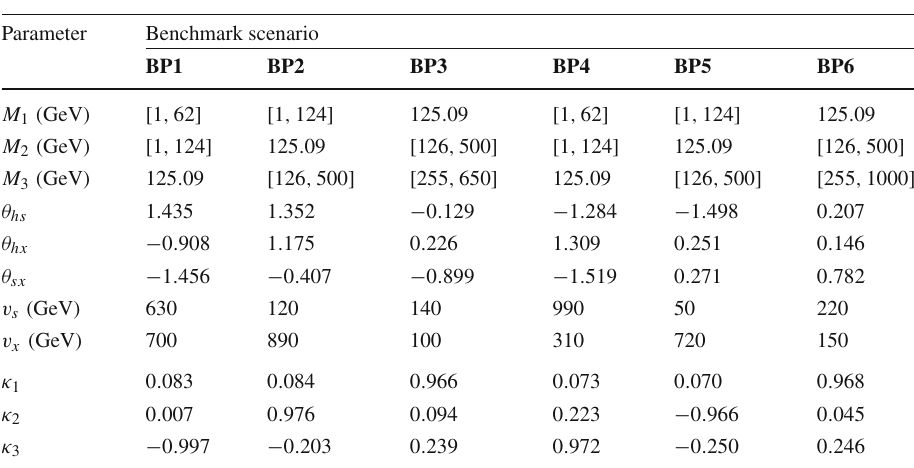
Table 1 Overview of the benchmark scenarios: The second column denotes the Higgs mass eigenstate that we identify with the observed Higgs boson, h 125 , the third column names the targeted decay mode of the resonantly produced Higgs state, and the fourth column lists possible relevant successive decays of the resulting Higgs states Table 2 Input parameter values and coupling scale factors, κ a ( a = 1 , 2 , 3), for the six defined benchmark scenarios. The doublet vev is set to v = 246 GeV for all